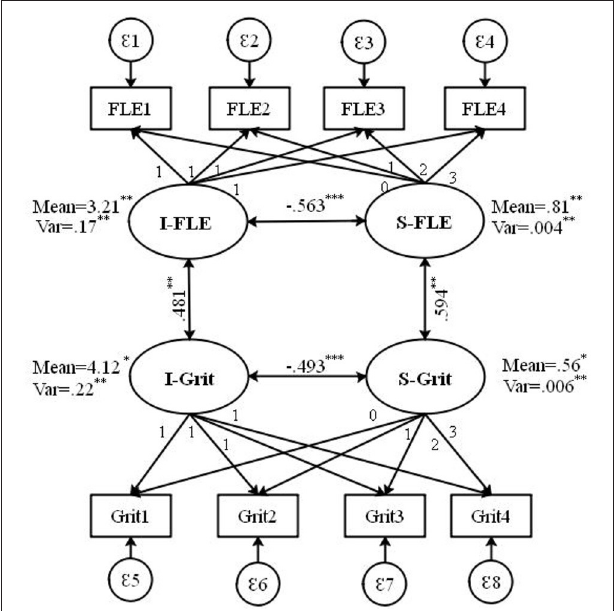
FIGURE 1 | Parallel process model (PPM). I, Initial Level; S, Slope; FLE, foreign language enjoyment; Grit, L2 grit. [ χ 2 ( df ) = 55.324(24), p < 0.001; CFI/TLI = 0.932/0.923; RMSEA ( 90% CI ) = 0.055 (0.039, 0.052); SRMR = 0.057]. * p < 0.05. ** p < 0.01. *** p <